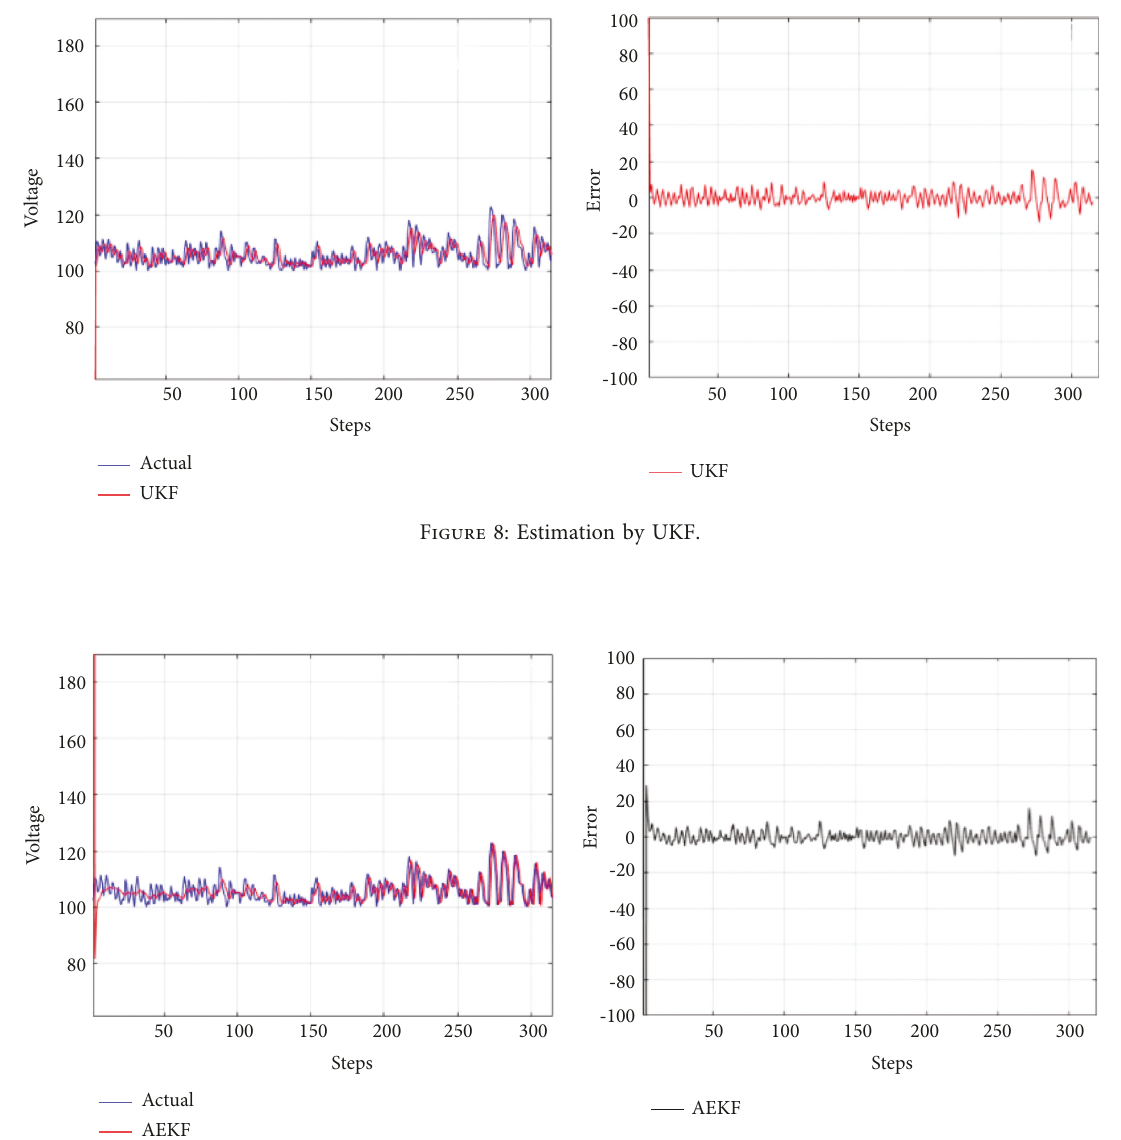
Figure 9: Estimation by